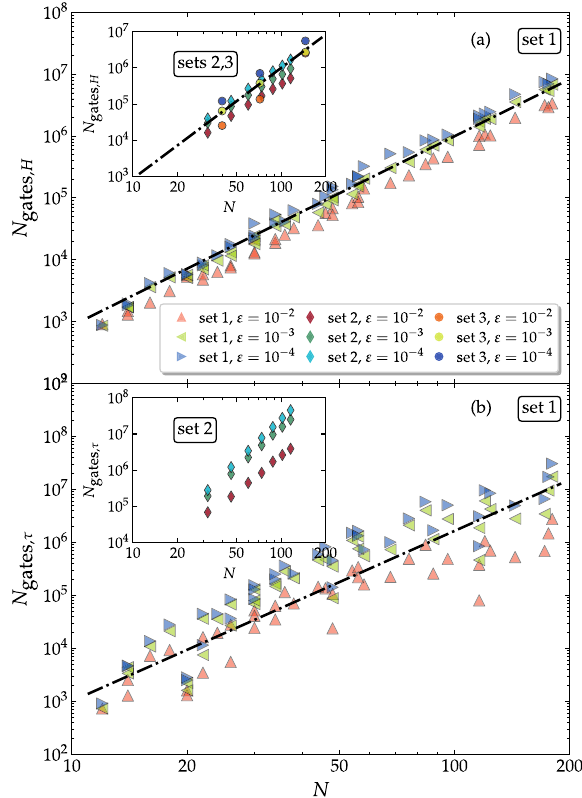
Fig. 3 Gate counts per Trotter step of the Hamiltonian and uCC operator, for ε CD = ε ET = ε SVD = 10 − 2 , 10 − 3 , and 10 − 4 (red, green, blue). Gate counts per Trotter step of the ( a ) Hamiltonian and ( b ) uCC operator. Black lines indicate power-law fi ts, with optimal exponents 3.06(3) and 3.2(1), respectively. Both gate counts scale as the third power of the basis size N across a wide range of truncation thresholds, an improvement over the O ( N 4 ) scaling assuming no truncation.